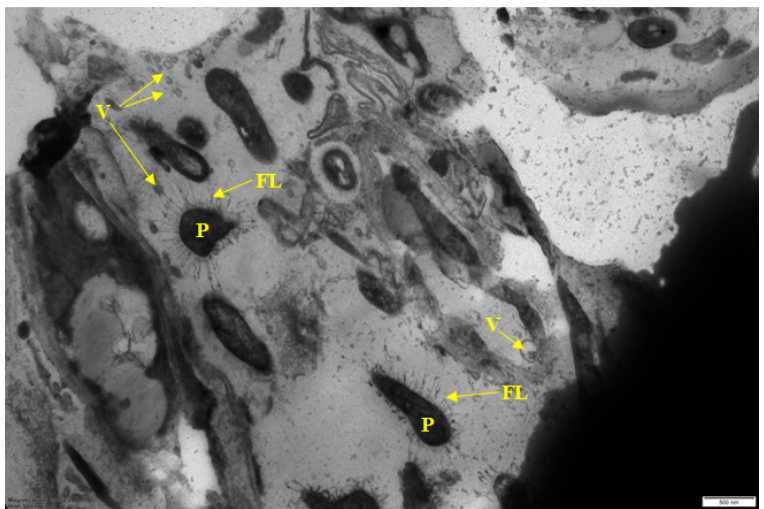
Figure 2. Electron micrograph of sample 1 biofilm (magnified). Designations: P—persisters covered with a fibrillar layer; FL—fibrillar layer; V—vesicle. Scale bar is 0.5 µm.